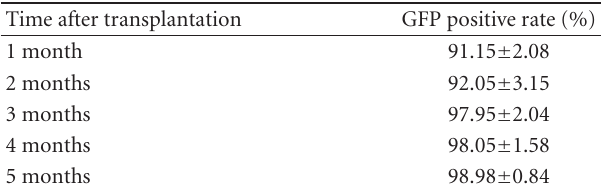
Table 1: The average percentage of GFP positive marrow cells in recipient’s bone marrow ( n = 3 at each